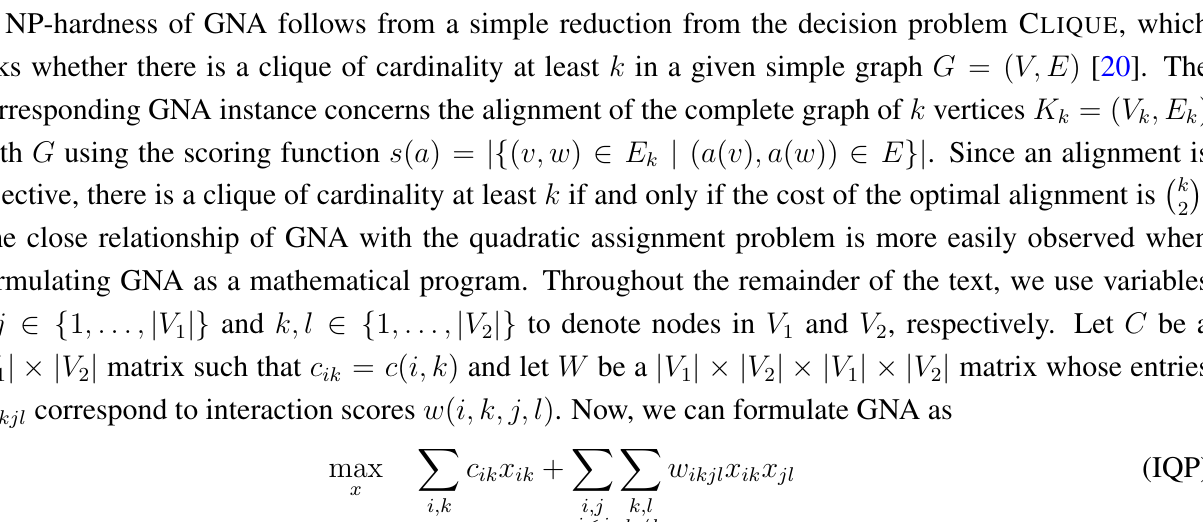
Figure 1. Example of a network alignment. With the given scoring function, the alignment has a score of 4 + 40 = 44